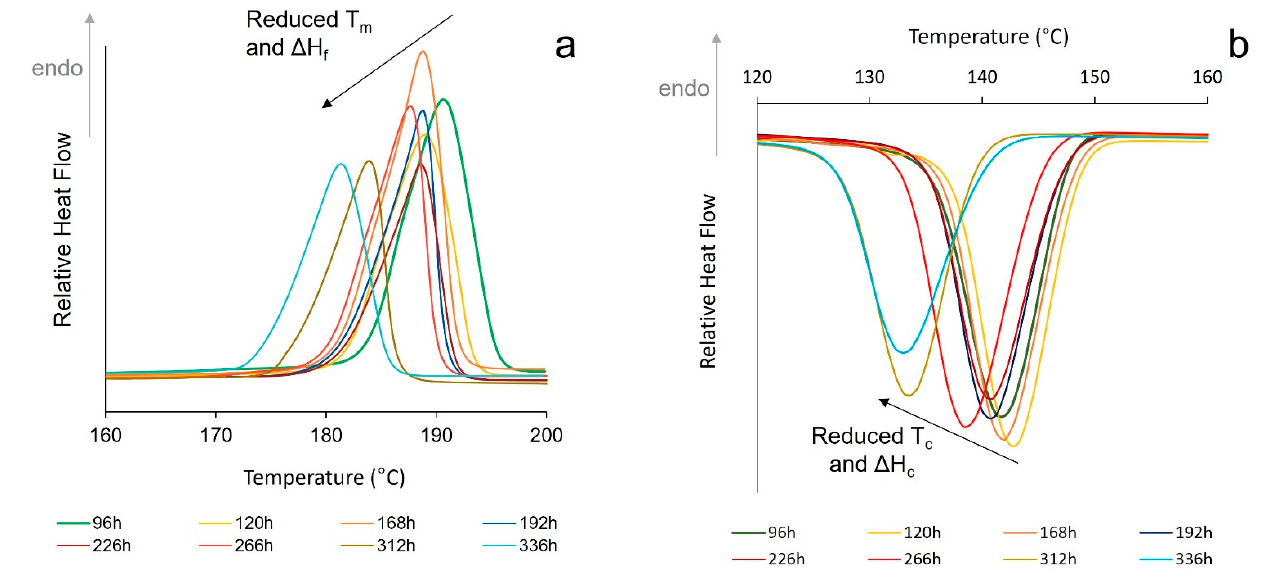
Figure 5. DSC first heat–cool showing the change in ( a ) melting behaviour and ( b ) crystallisation behaviour, for storage times greater than 100 h.